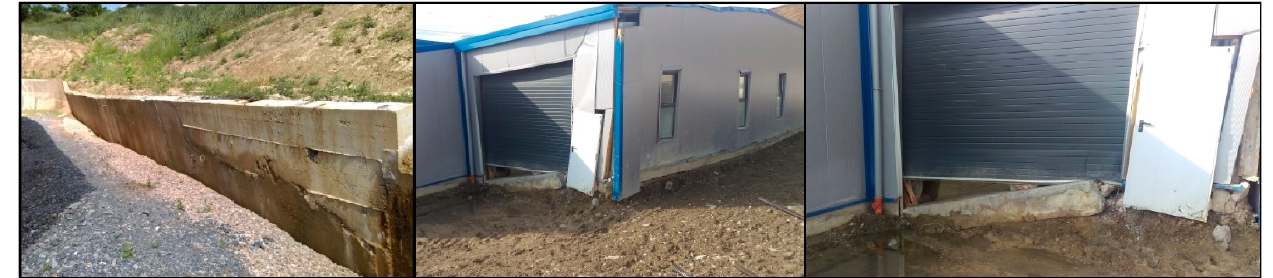
Figure 4. Collage of images depicting the old retaining wall right before failure, and the damages that ensued on the industrial production hall after the slope failure.